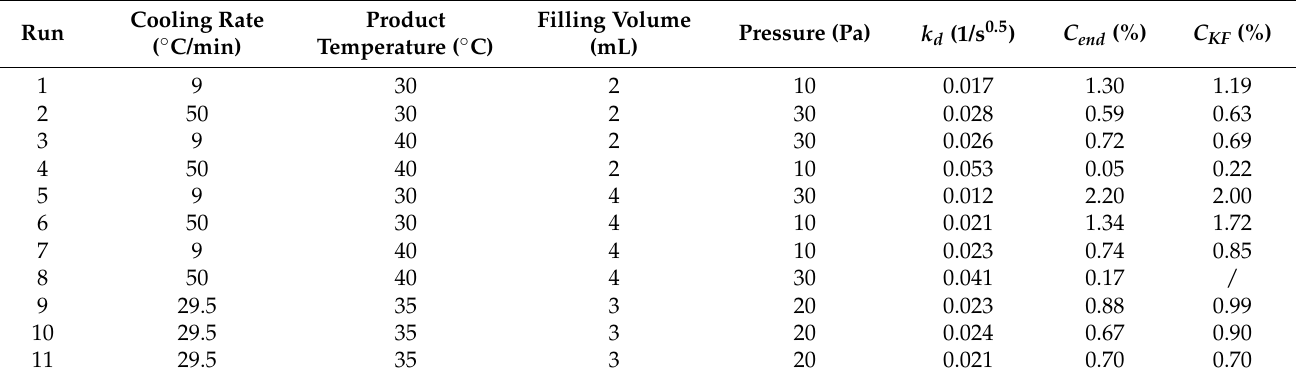
Table 1. Experimental design and